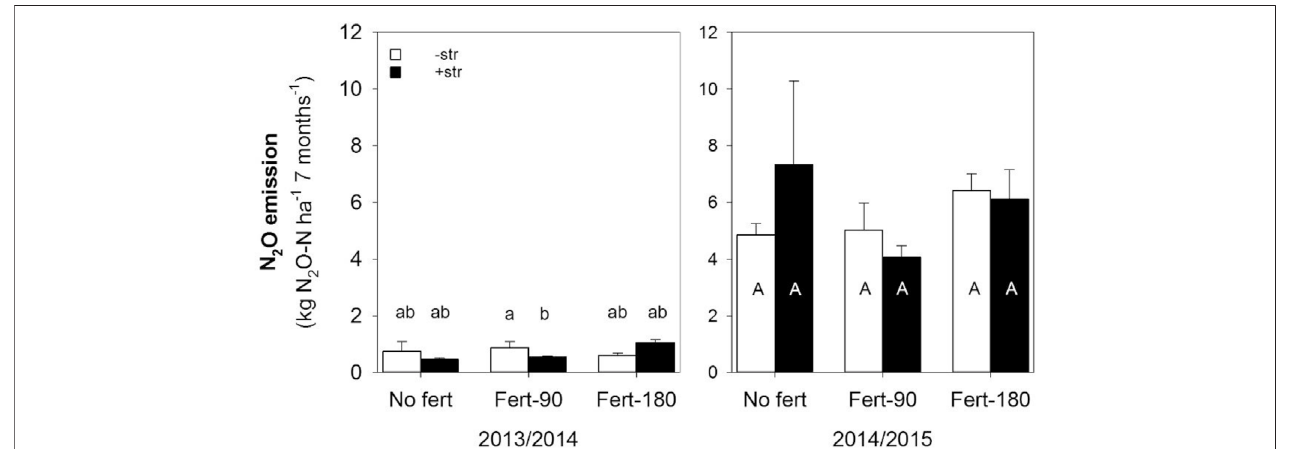
FIGURE 3| Cumulative N 2 O emissions from non-fertilized soils (No fert) and soils in springfertilized with 90 kg N ha − 1 (Fert-90) or 180 kg N ha − 1 (Fert-180) for the post-harvest period from August to March for the years 2013/2014 and 2014/2015, respectively. In all soils straw was quanti fi ed and either removed (-str) or quanti fi ed and placed back into the respective soils (+str). Error bars show the standard error of mean ofeach treatment ( n (cid:2) 3). Different letters indicate signi fi cant differences ( p < 0.05) among treatments. Periods 2013/2014 and 2014/2015 were analyzed